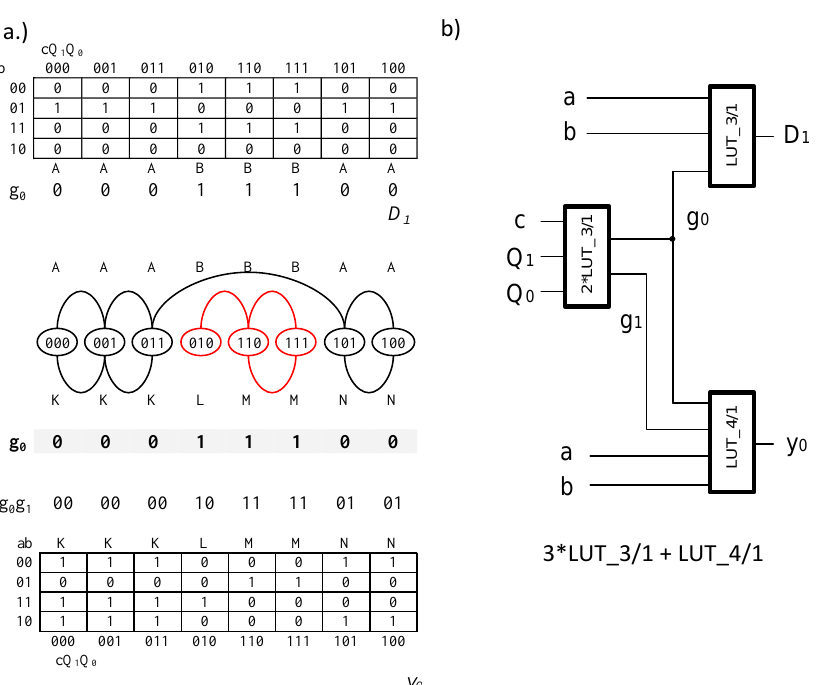
Figure 11. The limitation of the number of inputs in a free block using a common unicoding of the column patterns: ( a ) Karnaugh map of separate functions and a graph of columns’ compatibility; ( b ) a circuit’s carrying out using LUTs (look-up table).